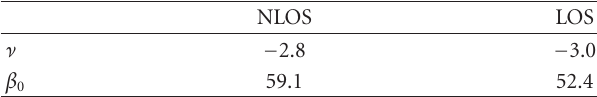
Table 2: Parameters of the first arriving multipath